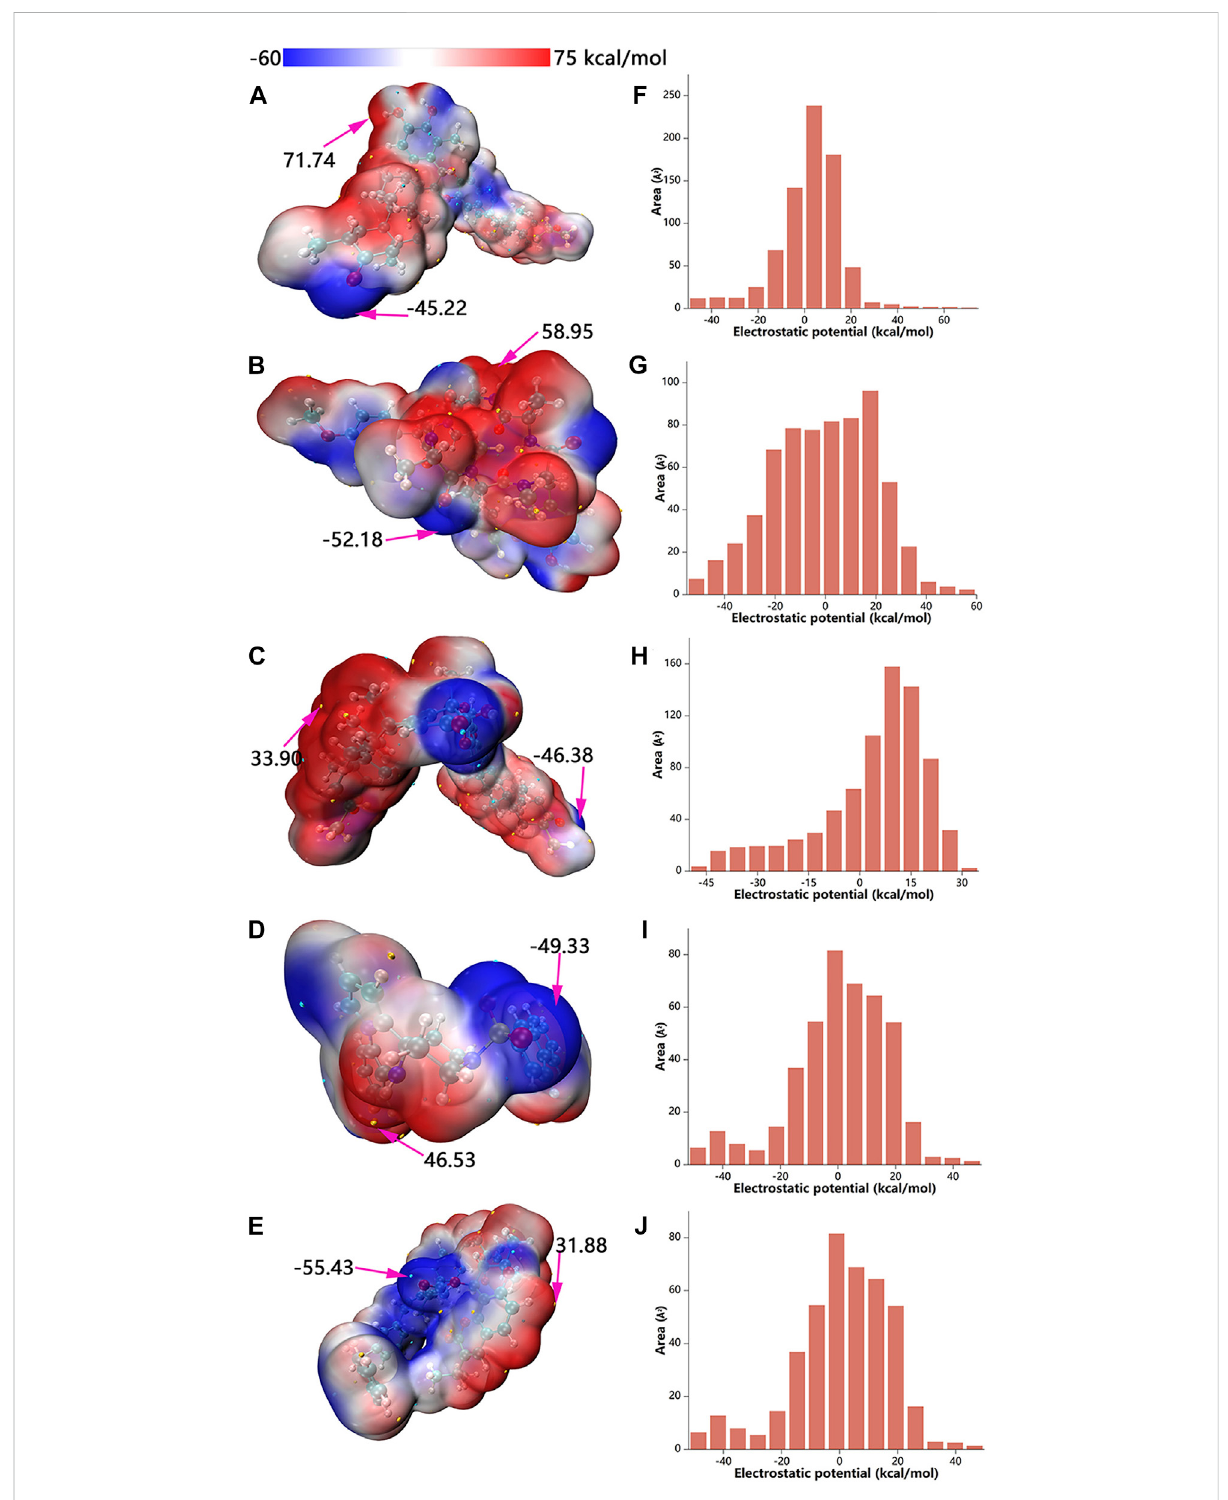
FIGURE 8 Electrostatic potential mapped molecular vdW surface (A – E) and surface area in each ESP range (F – J) . A, F: ZINC95919448; B, G: ZINC85531210; C, H: ZINC95610651; D, I: ZINC000035399302; E, J: ZINC95910594.